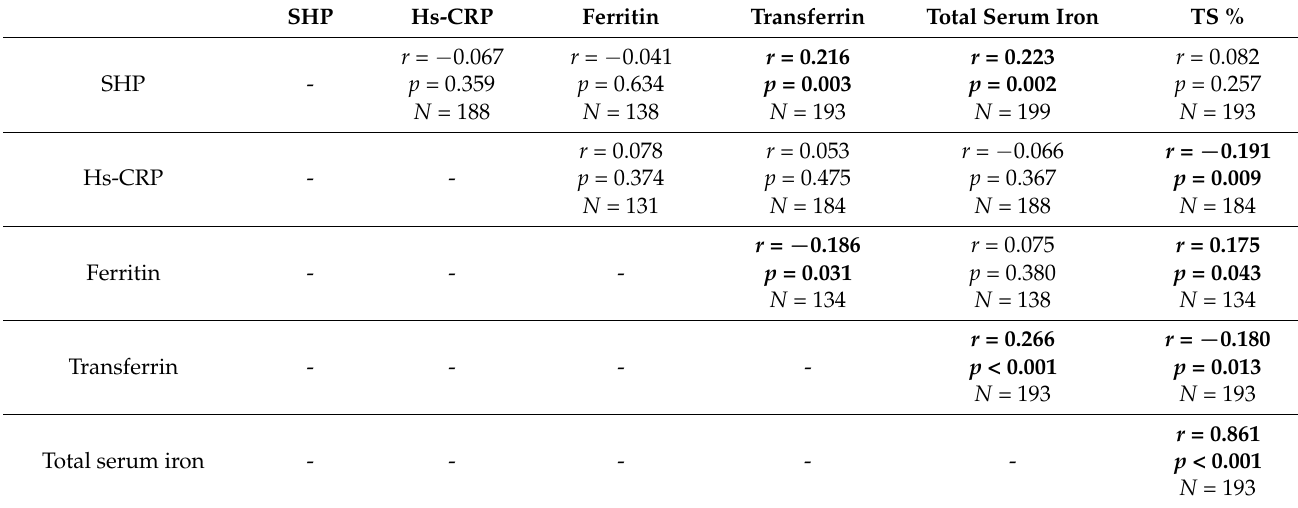
Table 4. Correlation matrix for biomarkers of oxidative stress, inflammation and body-iron stores.